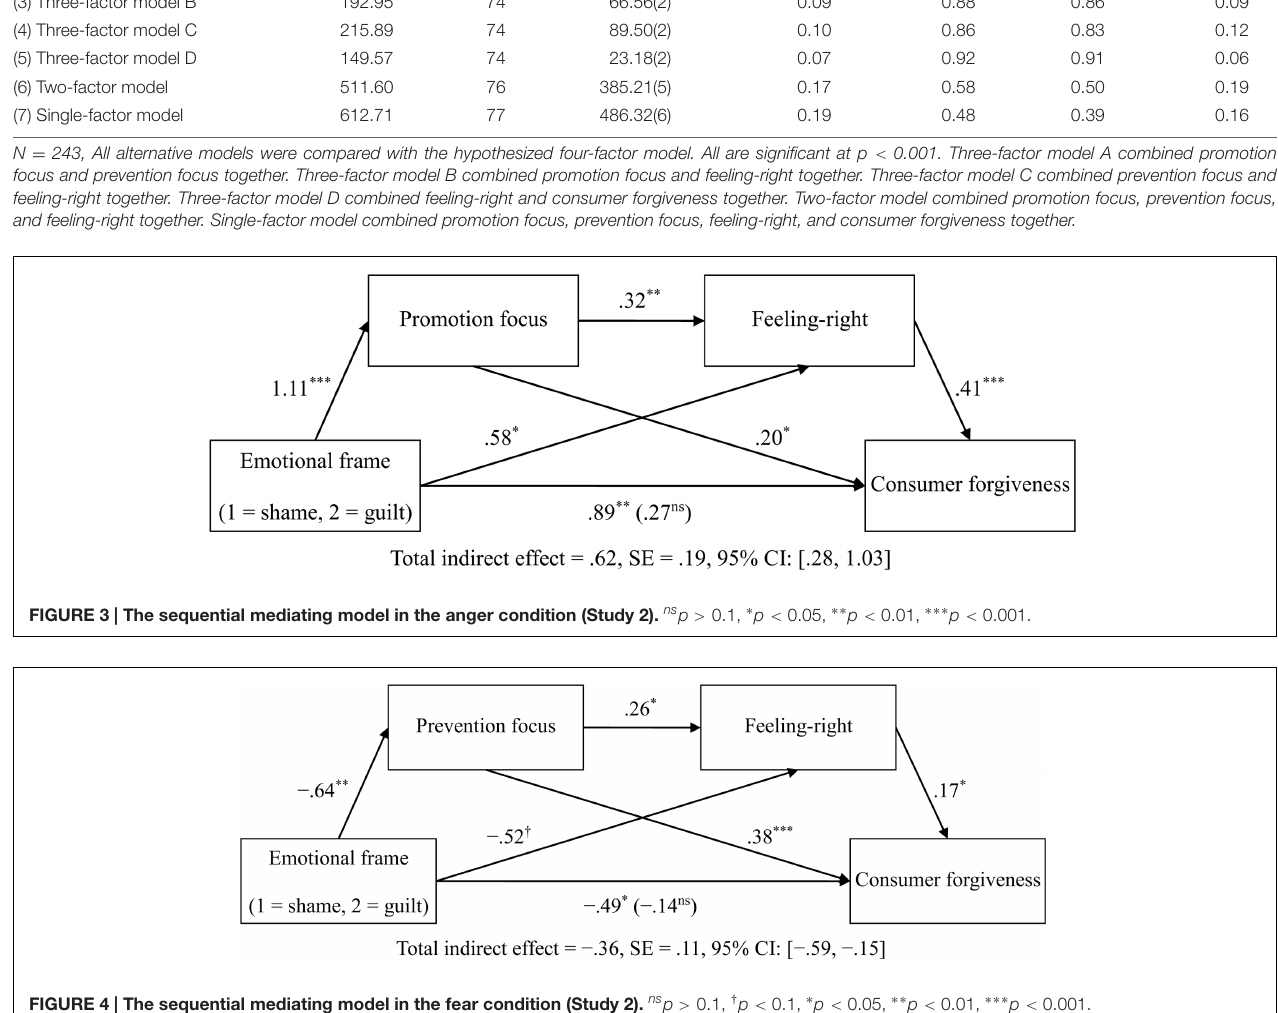
FIGURE 4 | The sequential mediating model in the fear condition (Study 2). ns p > 0.1, † p < 0.1, ∗ p < 0.05, ∗∗ p < 0.01, ∗∗∗ p <